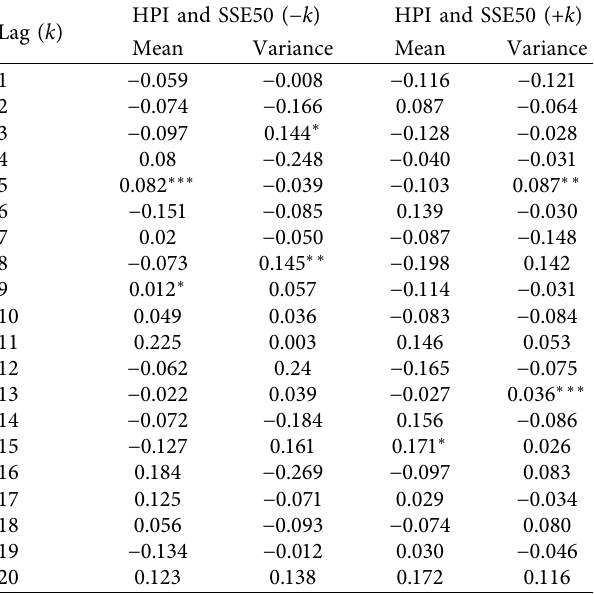
Table 4: Results of cross-correlation test.